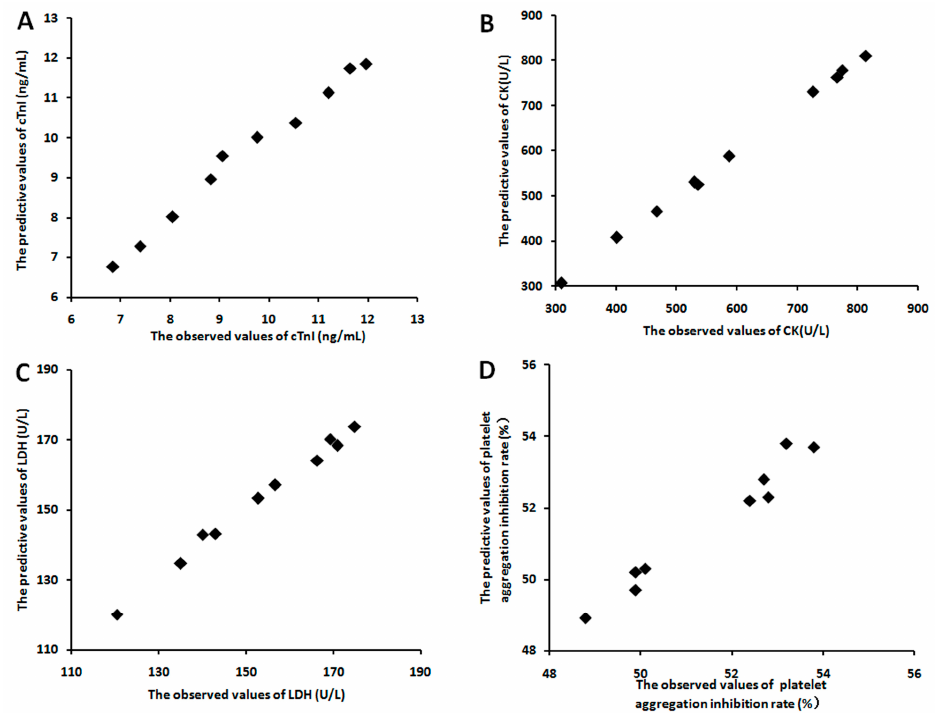
Figure 4. The diagram between the observed effects and the predictive effects in vivo studies in example 2. ( A ) cTnI; ( B ) CK; ( C ) LDH; ( D ) Platelet aggregation inhibition rate.